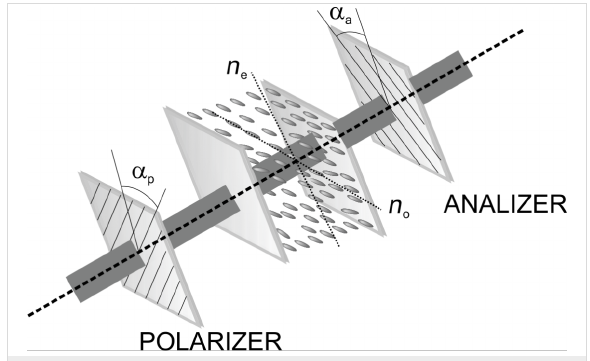
Figure 1: Schematic representation of a laser beam ( λ = 632.8 nm) passing through a planar nematic cell placed between crossed polar-